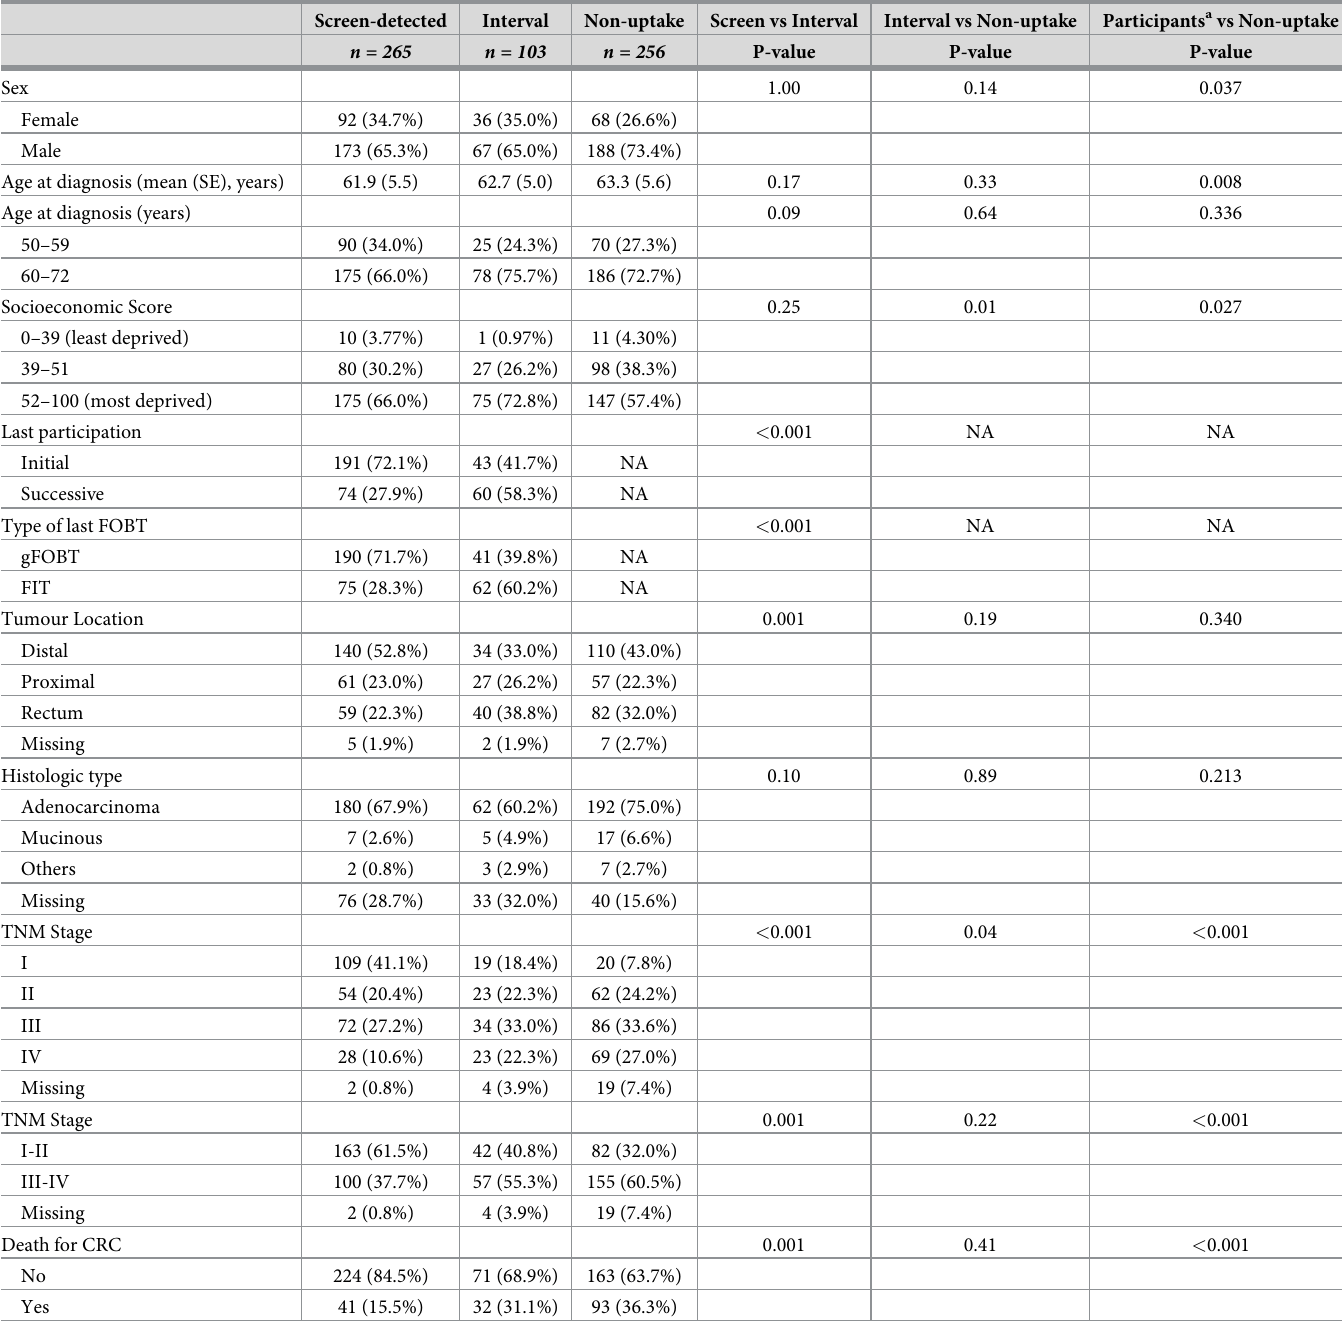
Table 1. Characteristics of colorectal cancer according to type of